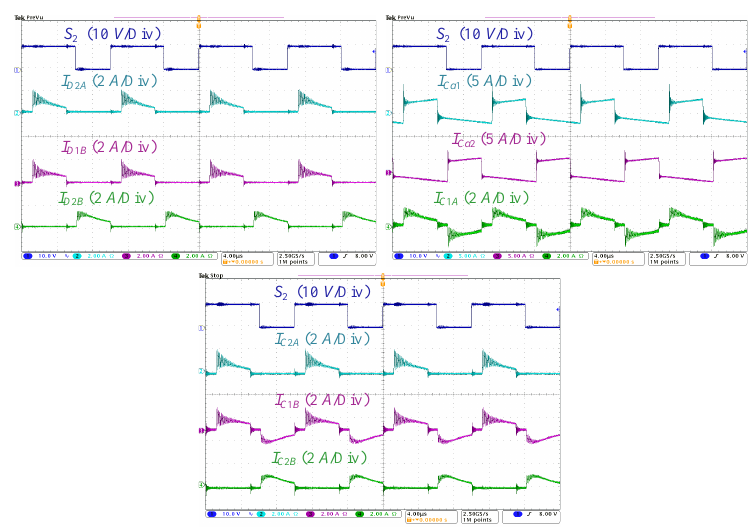
Figure 13. Currents waveforms of the VMC diodes, VMC capacitors and C a 1 and C a 2 .